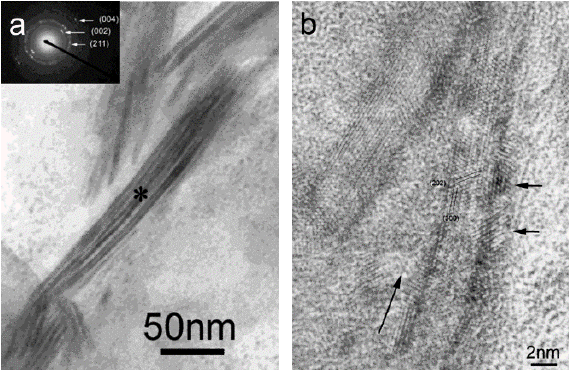
Figure 2. ( a ) Higher magnification of the mineralized collagen fibrils. Insert is the selected area electron diffraction pattern of the mineralized collagen fibrils. The asterisk is the center of the area and the diameter of the area is about 200 nm. ( b ) High-resolution transmission electron microscopy (HR-TEM) image of mineralized collagen fibrils. Long arrow indicates the longitude direction of the collagen fibril. Two short arrows indicate two hydroxyapatite (HA) nanocrystals. Reprinted with permission from reference [44].